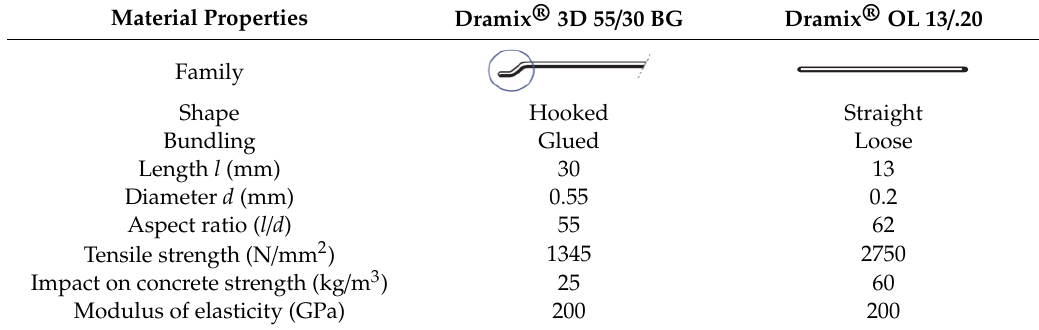
Figure 4. Steel fibers: ( a ) Dramix® 3D 55/30 BG (hooked fibers); ( b ) Dramix® OL 13/.20 (straight fibers). Table 1. General characteristics of fibers.